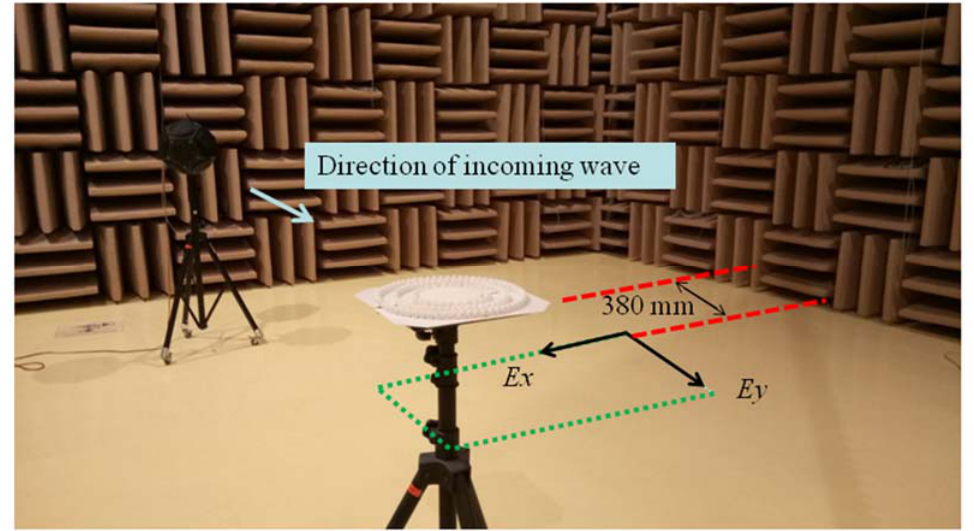
Figure 27. The scattering far field was measured using a single free-field microphone scanned in the forward scattering region between Ex = 0~760 mm and Ey = 0~190 mm, as indicated by the dotted line. The measurement step size is 19 mm in both directions. Appl. Sci. 2017 , 7 , 456